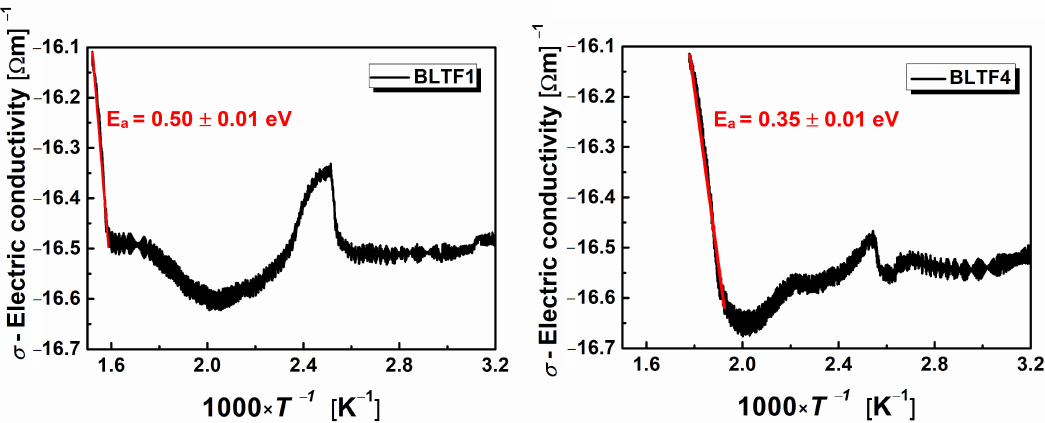
Figure 6. Temperature dependence of conductivity characteristic for BLTF